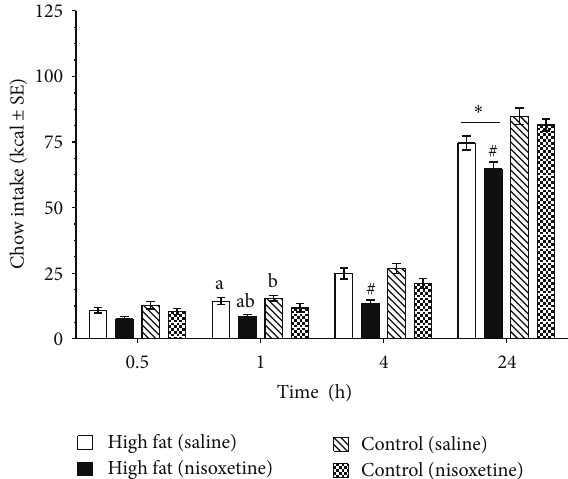
F 4: Diet-induced changes to the feeding suppression of a subthreshold nisoxetine dose. Following a 10-week feeding of high- fat or control diets, all rats were given a 24h food deprivation and then fed standard chow. Animals were injected (IP) with either nisoxetine (3mg/kg) or saline. One week later the injections were counterbalanced. Rats exposed to a high-fat diet showed a higher sensitivity to feeding suppression of nisoxetine at 4 and 24 hours. Animals exposed to the high-fat diet had an overall reduced intake of chow at 24h, which is indicated by ( ). Similar letters indicate signi�cance from each other ( ). # indicates difference ( ) from all groups at the individual time ∗ 𝑃𝑃 𝑃 𝑃𝑃𝑃𝑃 𝑃𝑃 𝑃 𝑃𝑃𝑃𝑃 𝑃𝑃 𝑃 𝑃𝑃𝑃𝑃